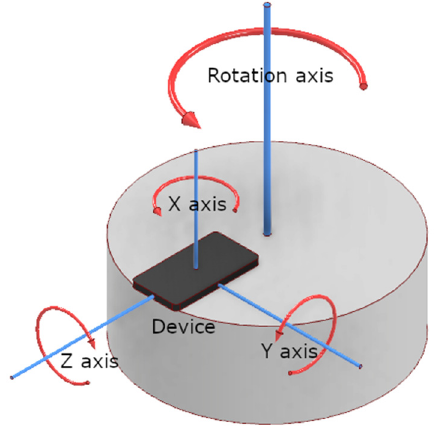
Figure 9. The principle of dynamic IMU measurements implemented in previous research (measurements on platforms rotating at constant rotation speed).